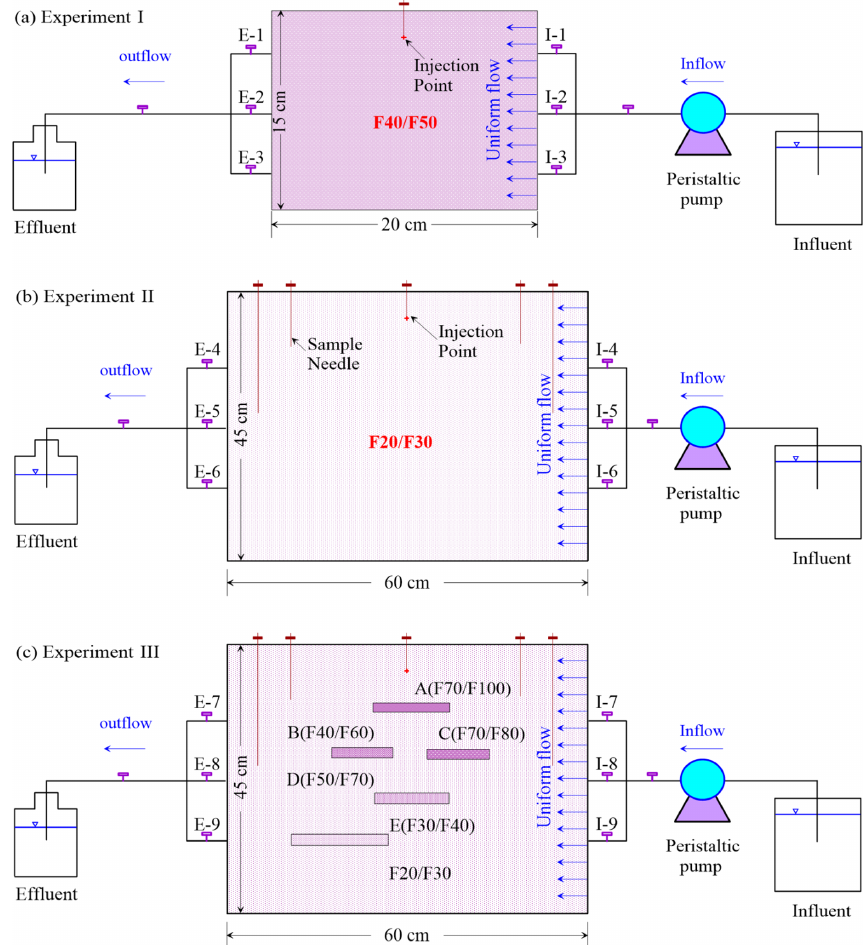
Figure 2. (a) The system sandbox equipment of Experiment I; (b) the system sandbox equipment of Experiment II; (c) the system sandbox equipment of Experiment